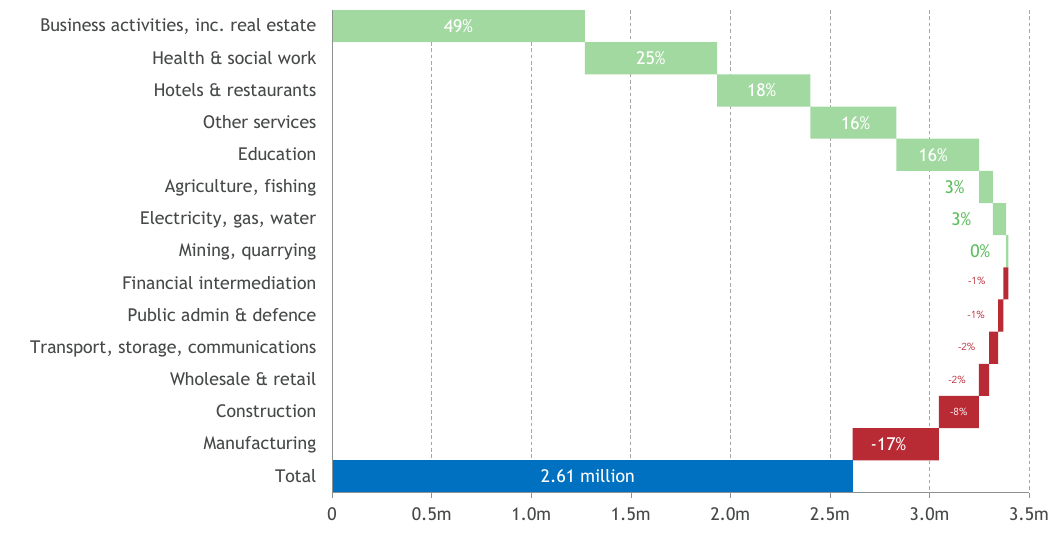
Figure 21: Employment has grown most in the business activities, health and hospitality sectors Contribution to change in employment: